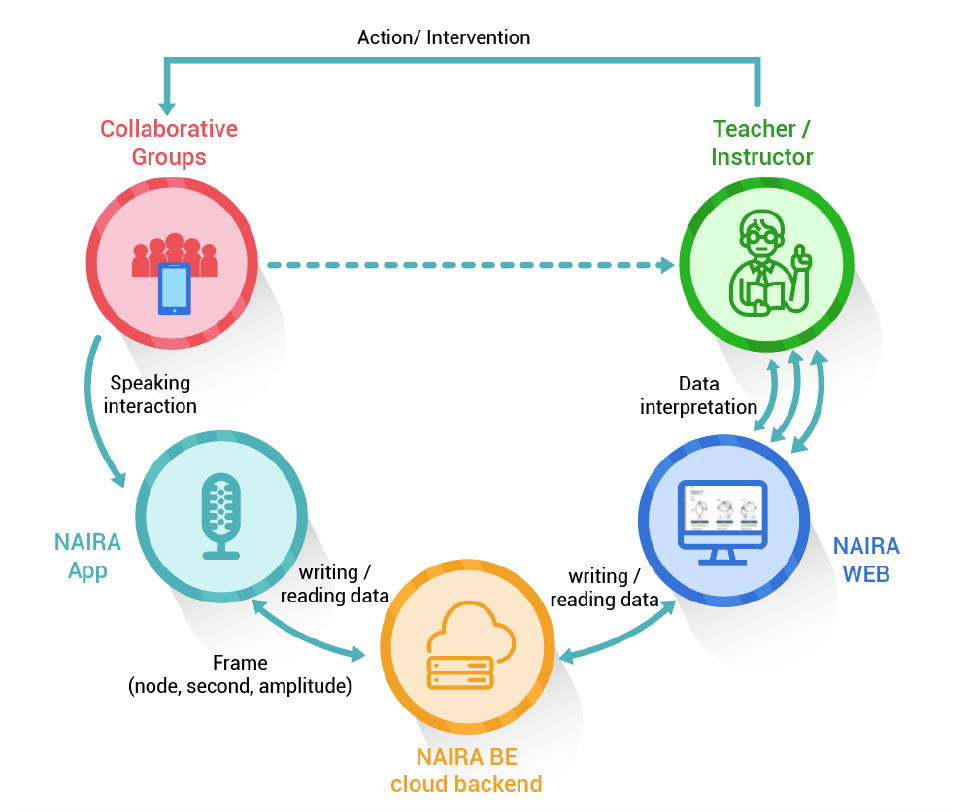
Figure 1. General diagram of the proposed